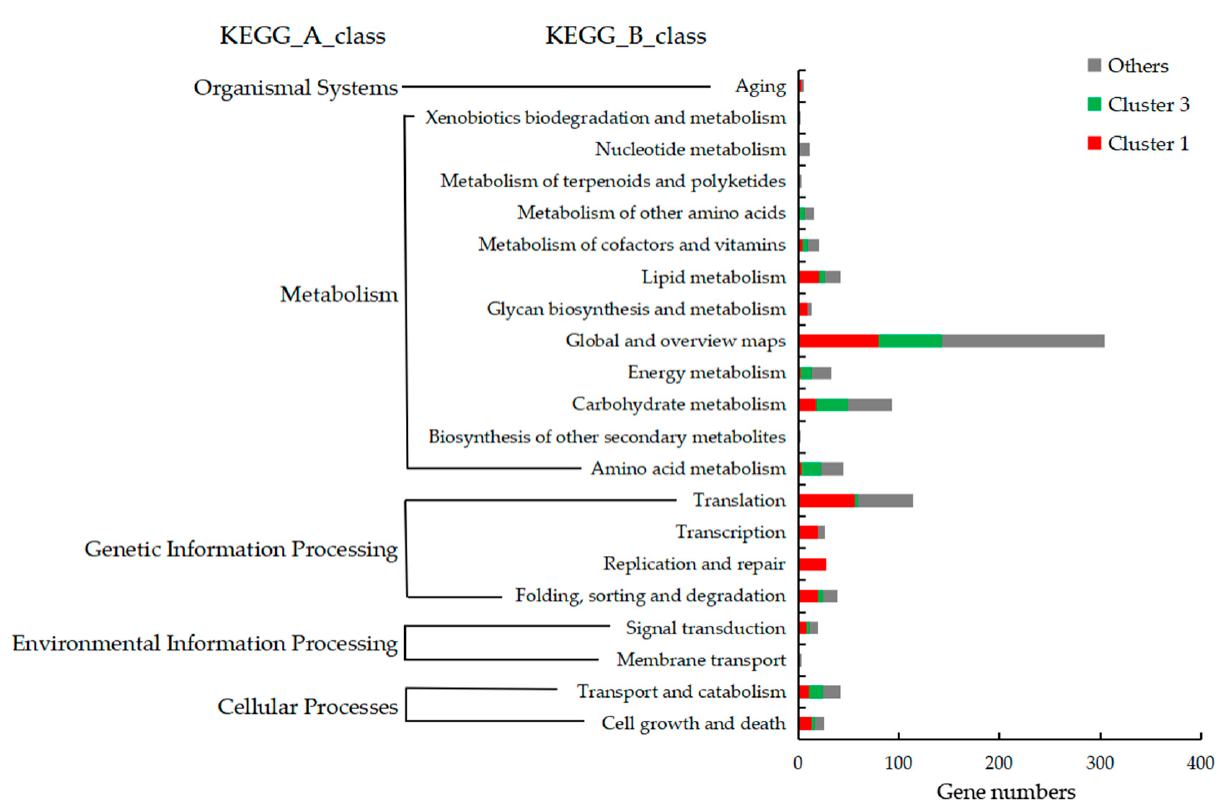
Figure 7. Kyoto Encyclopedia of Genes and Genomes (KEGG) classification of DEGs among different groups.